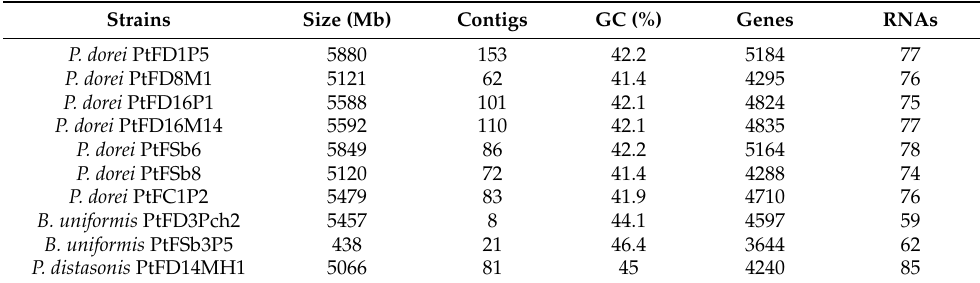
Figure 7. Genome map of P. dorei PtFD16P1 ( a ), B. uniformis PtFD3Pch2 ( b ), and P. distasonis PtFD14MH1 ( c ). The outermost ring depicts the coding sequences in both clockwise and anti-clockwise direction. tRNA is depicted as red arrow heads, rRNA in orange and tmRNA in royal blue. CRISPR repeats regions are coloured in lime green. GC skewing is shown in green and purple, and GC content in black. Table 1. Genomic features of the analyzed